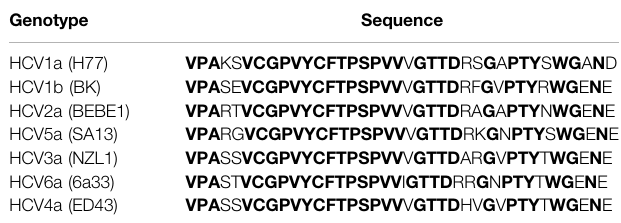
TABLE9| Alignmentofsegment497 – 533fromvariousgenotypesofHCV.Inbold are represented the fully conserved residues.